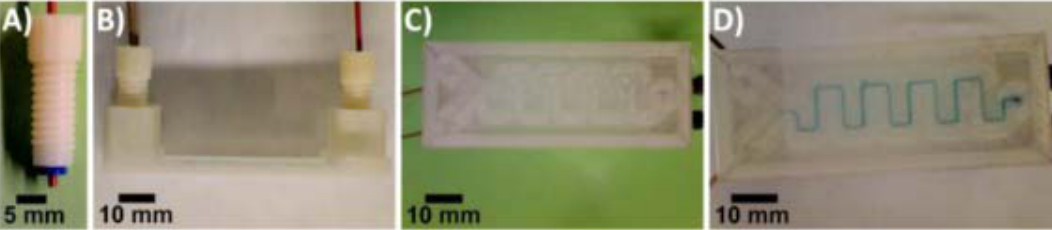
Figure 10. Preparation of Prussian blue nanoparticles (PBNPs) using a 3D ‐ printed Y ‐ shaped mixing device. ( A ) D ‐ printed ABS fitting ( B ) side view of the device ( C ) bottom view of the device ( D ) bottom view of the device after mixing 5 mM iron (II) chloride and 5 mM potassium ferricyanide solutions to form citrate ‐ PBNP. (Reproduced with permission from [33].)